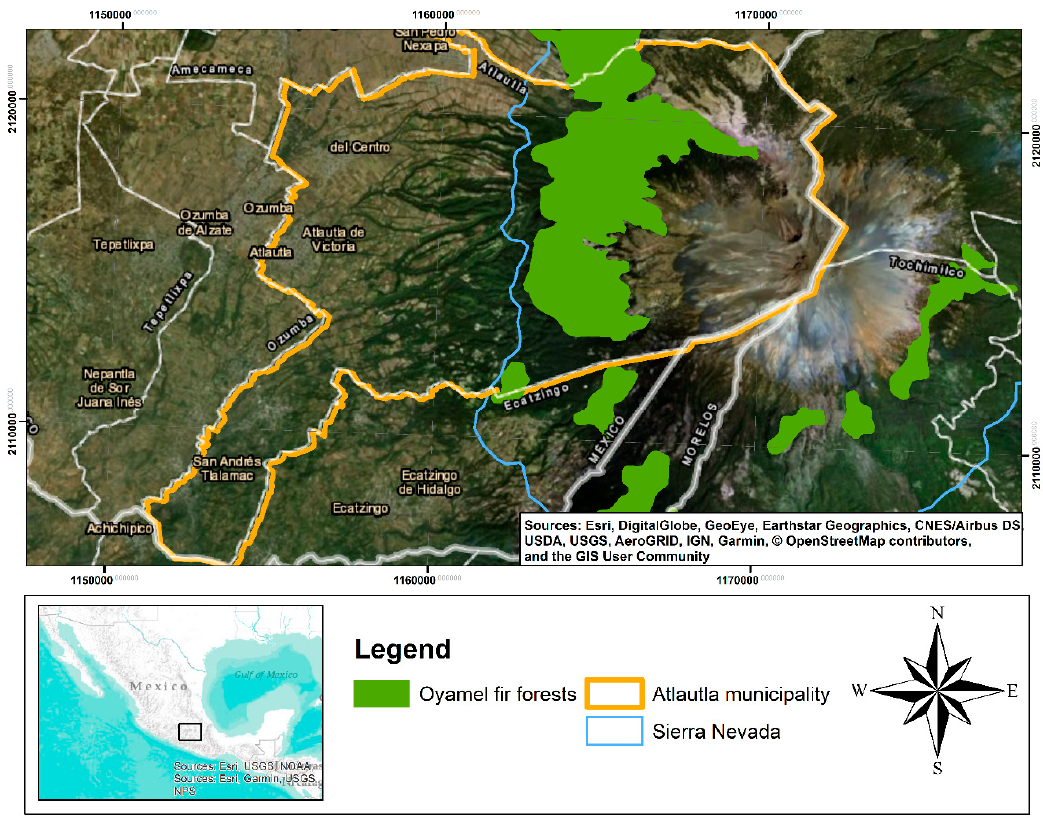
Figure 2. Location of the monarch butterfly in the Atlautla municipality.